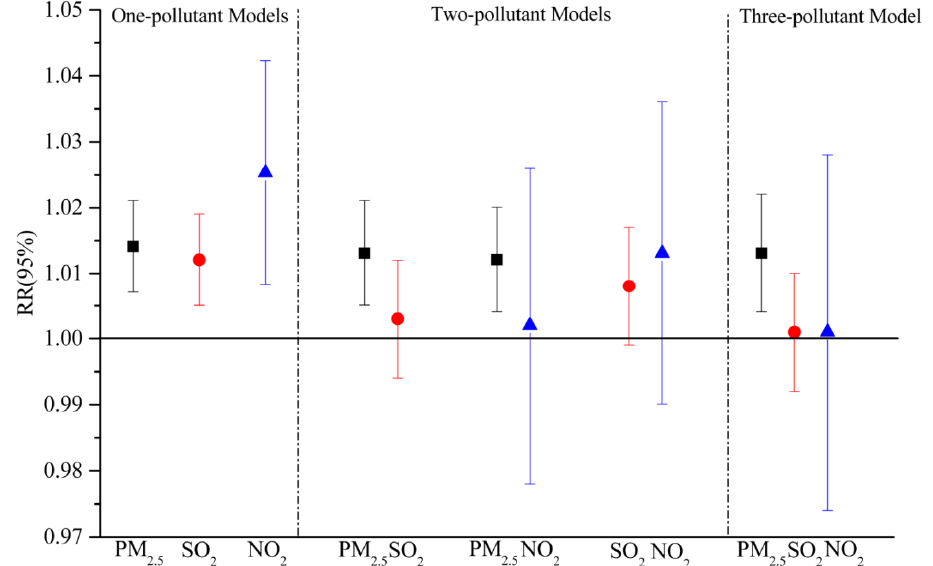
Figure 4. Adjusted estimated relative risks (RRs with 95% CI) of emergency room visits due to respiratory complaints with per 10 µ g/m 3 increase in PM 2.5 , SO 2 and NO 2 in multi-pollutant models for the urban population in Jinan.